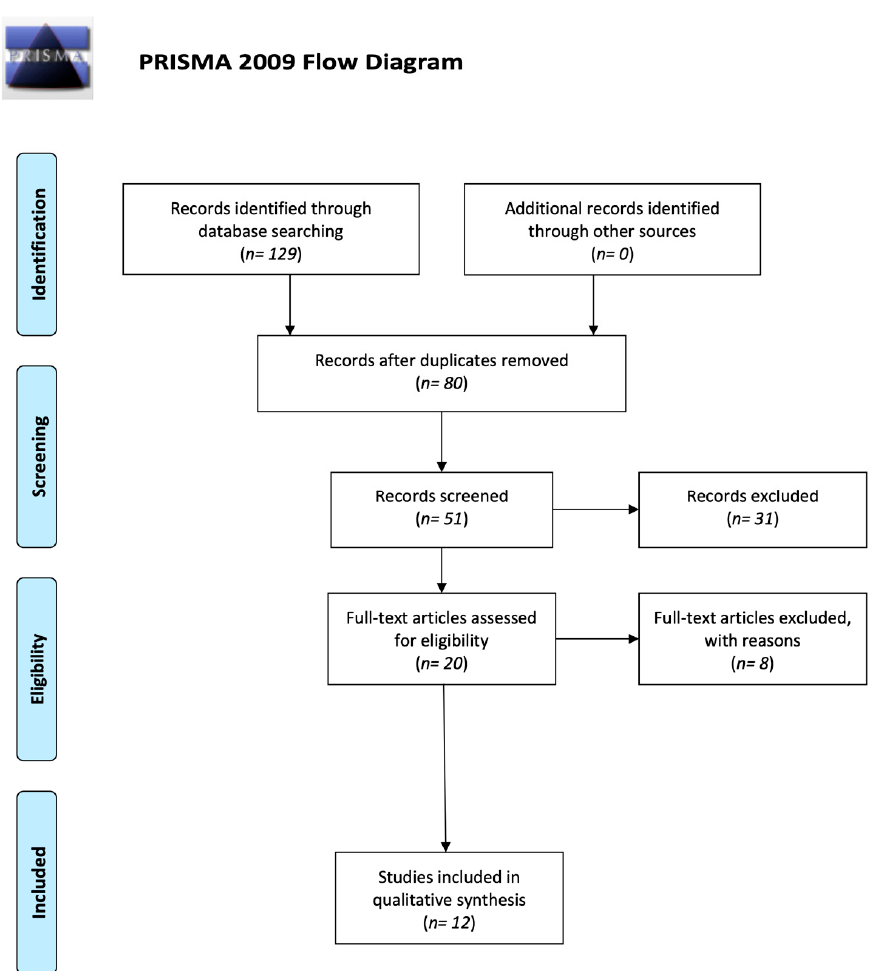
Figure 1. Preferred Reporting Items for Systematic Reviews and Meta-Analyses (PRISMA) flow chart.